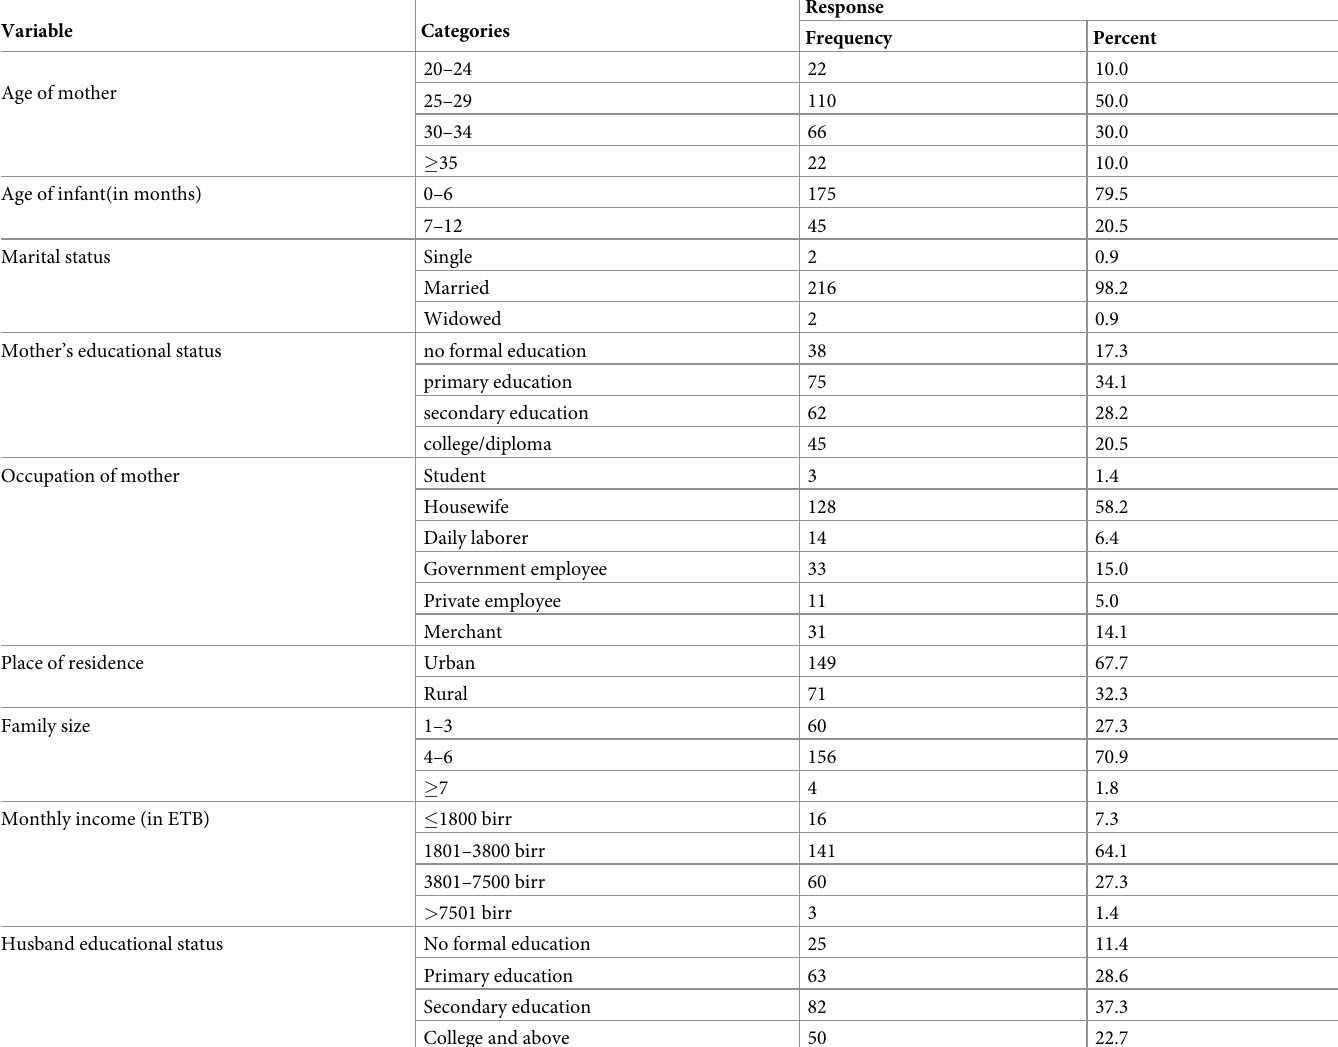
Table 1. Sociodemographic characteristics of a mother attending the EPI unit at WUSH, 2021.